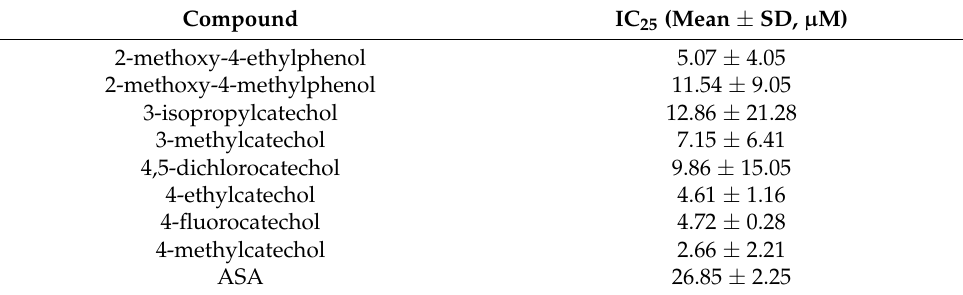
Figure 5. Dose–response Curves of the Most Efficient and Safe Compounds on Collagen-induced Platelet Aggregation. 4,5-dichlorcatechol is not shown since it blocked cell proliferation at 100 µ M. Table 2. IC 25 on Collagen-Induced Platelet